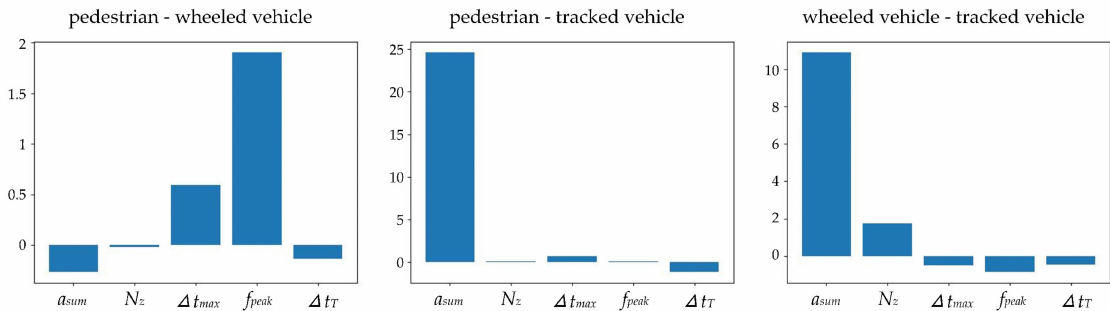
Figure 11. Feature importance of SVM with linear kernel